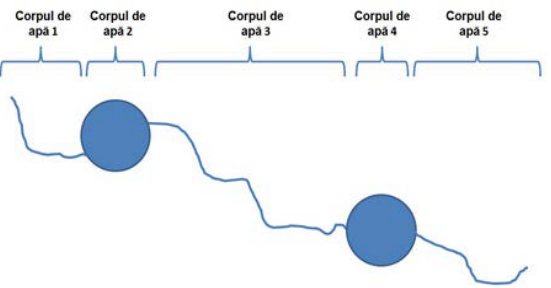
Figure 7. The Delineation of the Water Bodies scheme.